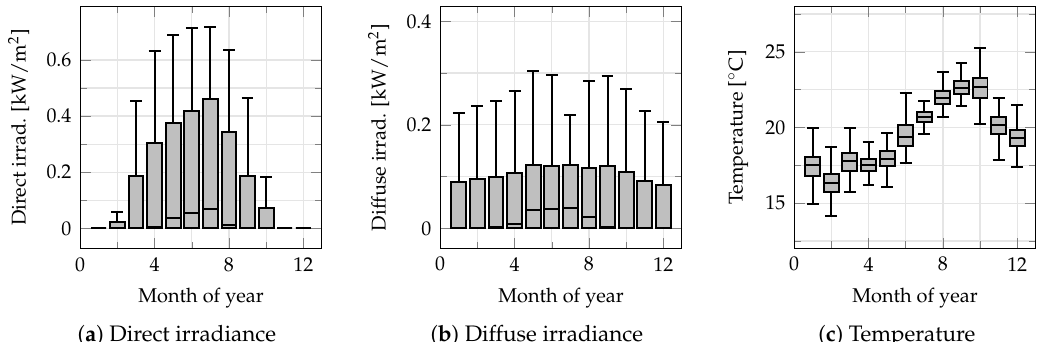
Figure 4. Seasonal variability in hourly irradiance components ( a , b ) and temperature ( c ) measurements for La Graciosa illustrated using box plots in monthly